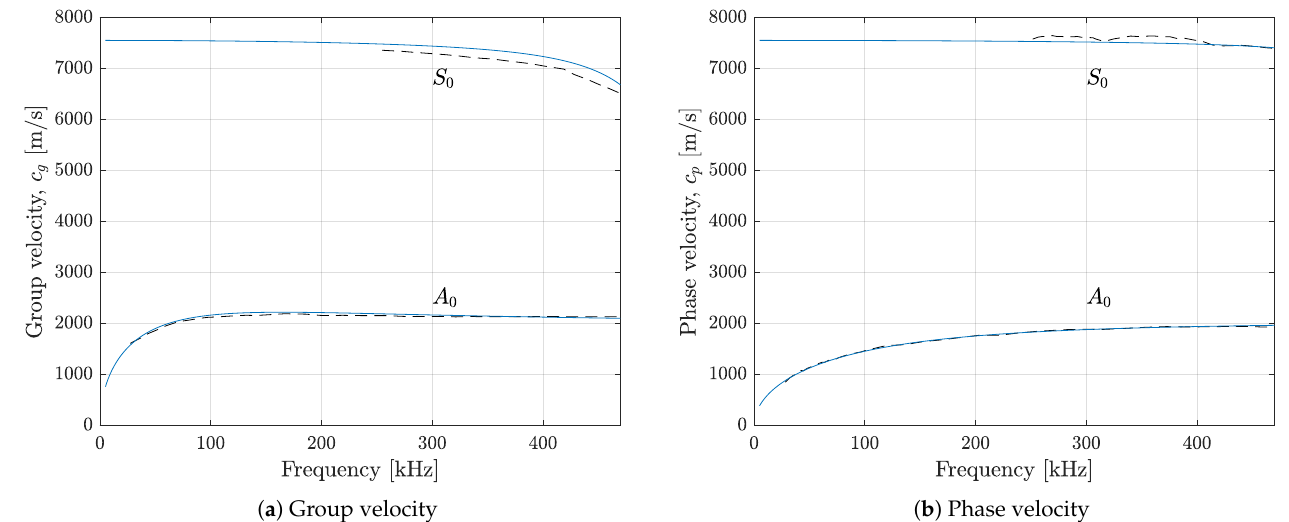
Figure 6. Dispersion curves along the principal direction 1 of 0 ◦ lamina for [ 0/90/0 ] s laminate obtained using the FE (- -) and WFE (–) methods.